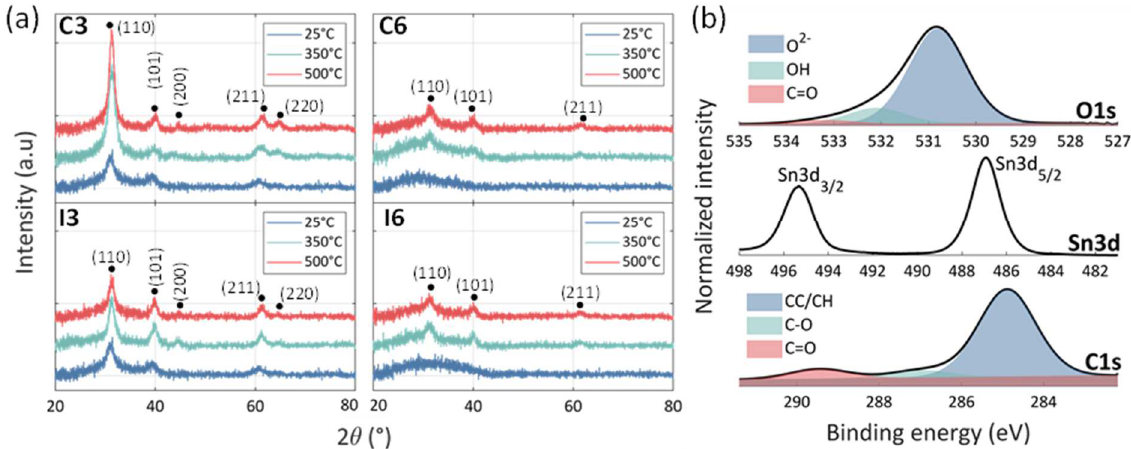
Figure 2. ( a ) XRD patterns of SnO 2 thin films sputter deposited on glass substrates before and after an annealing treatment in ambient air for 48 h at 2 different temperatures (350 and 500 °C). ( b ) XPS O1s, Sn3d, and C1s spectral windows of the I6 SnO 2 thin film sputter deposited on (100) Si substrate after an annealing treatment in ambient air at 500 ◦ C for 48 h.